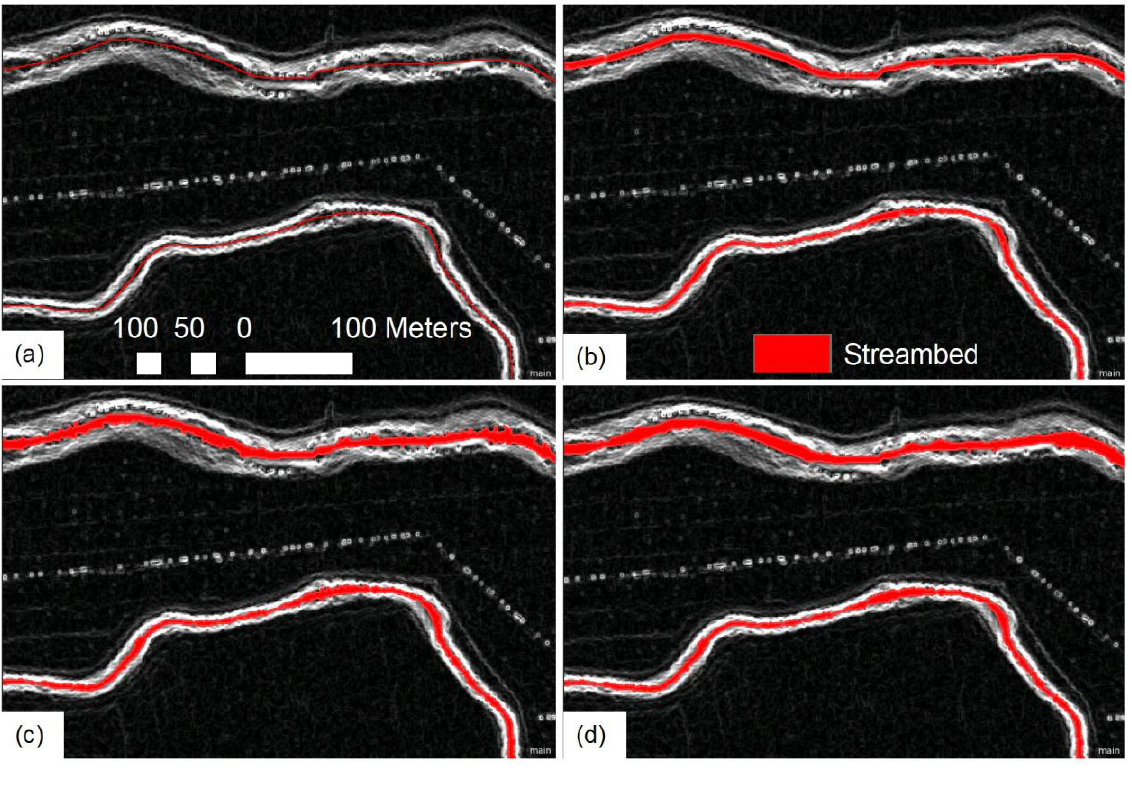
Figure 4. Mapping the streambed from the LiDAR derived DTM and slope layers and a rasterized polyline representing the stream centerline. The slope layer is used as a backdrop. (a) Classification of stream centerline using multi-threshold segmentation; (b) Pixel-based object growing of centerline; (c) Further pixel-based object growing based on the DTM and slope; (d) Final extent of streambed after